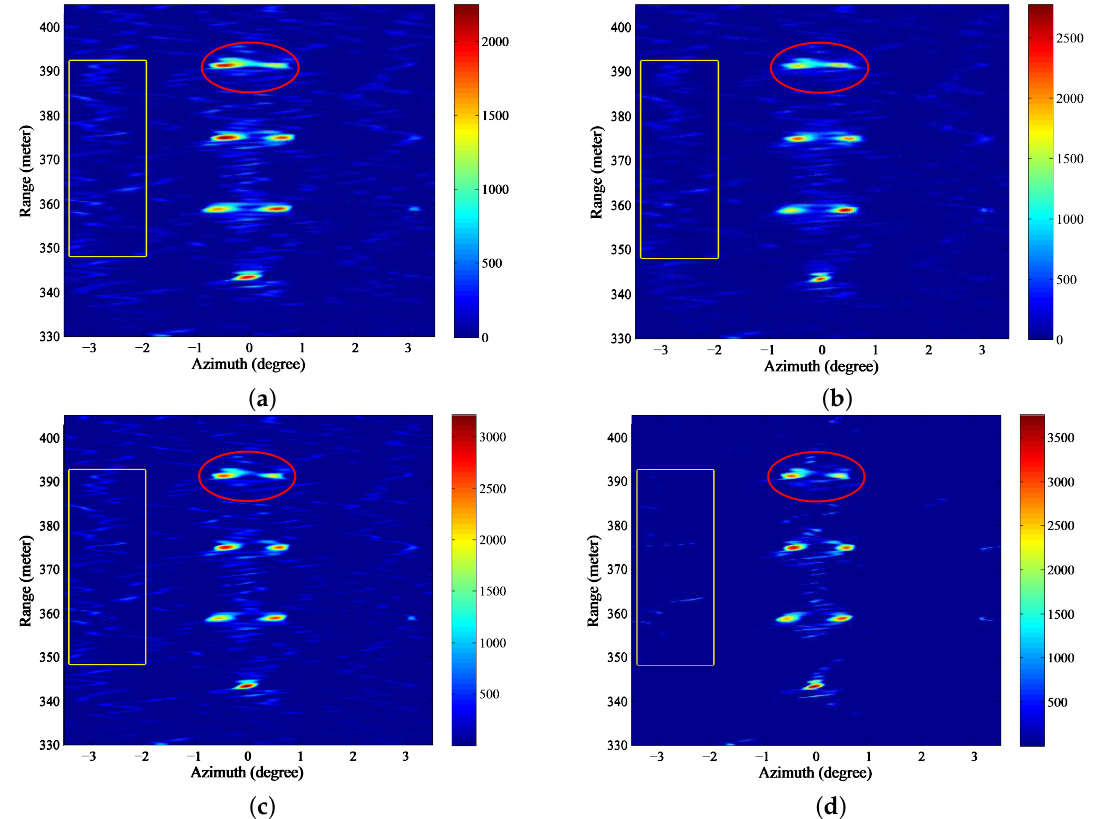
Figure 13. Angular super-resolution results for real beam data through manually adjusting the iteration numbers ( a ) Landweber; ( b ) Richardson-Lucy (RL) ( c ) maximum a posterior (MAP)( d ) proposed penalized maximum likelihood (PML).